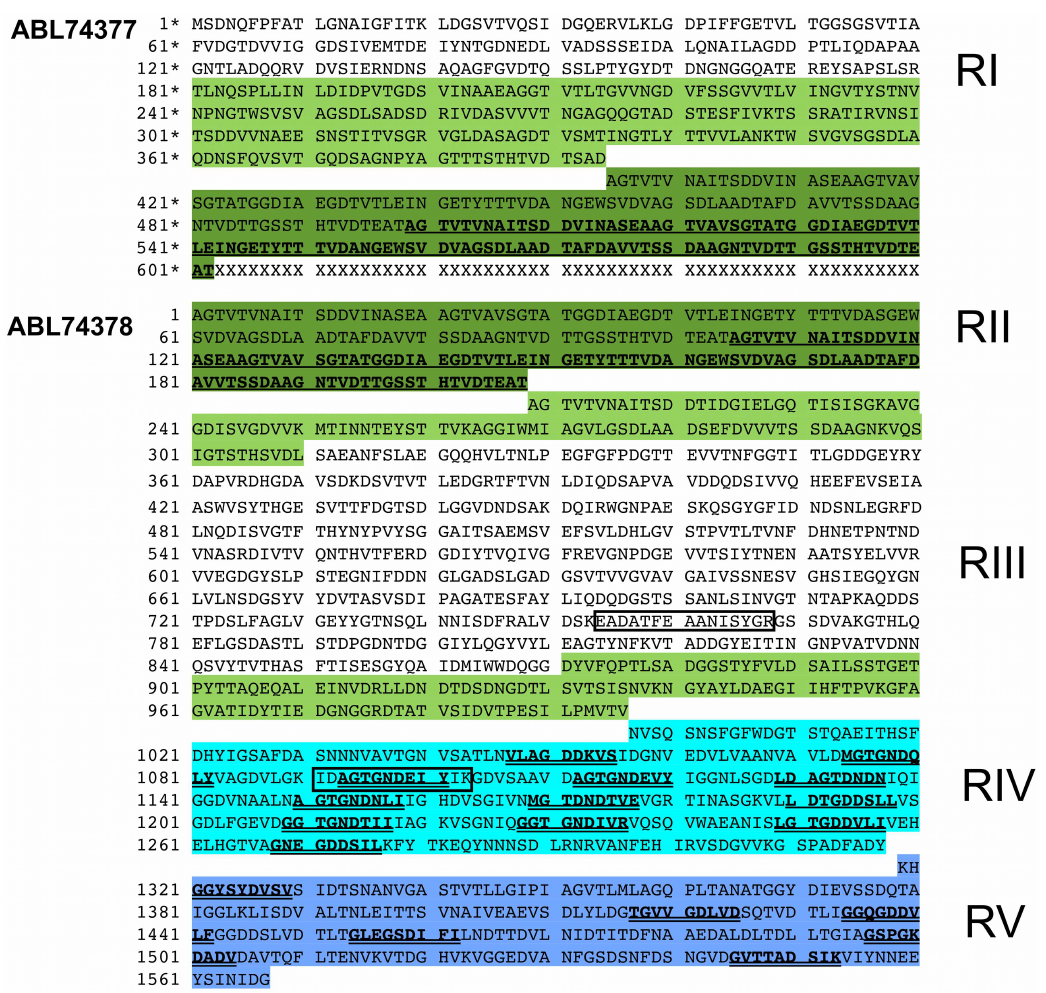
Figure 3. Amino acid sequence of Mp AFP. The complete amino acid sequence of Mp AFP is divided into five distinct regions (RI–RV). Because it was not possible to sequence through the DNA encoding the highly repetitive RII ( , 120 identical 104-aa repeats), the protein was deposited in NCBI with two accession codes: ABL74377 and ABL74378. The two segments of Mp AFP are separated by a line of ‘‘Xs’’. The first segment of Mp AFP contains RI and two 104-aa repeats of RII. The residues are identified with asterisks (1*–602*). The second segment begins with two 104-aa repeats of RII and continues through RIII, RIV and RV, with the residues identified by regular numbers (1–1567). The color scheme for the highlighted residues corresponds to that of Fig. 6. The second 104-aa repeat of RII is indicated in bold underlined letters in both segments of Mp AFP. The nine-residue RTX-like repeats in RIV and RV are represented by bold double-underlined letters. The boxed sequences EADATFEAANISVGR and IDAGTGNDEIYIK are the two sequenced tryptic peptides identified by tandem MS/MS (Table S1) that were used to design degenerate PCR primers that amplified the first nucleic acid probe used for the isolation of the Mp AFP gene.